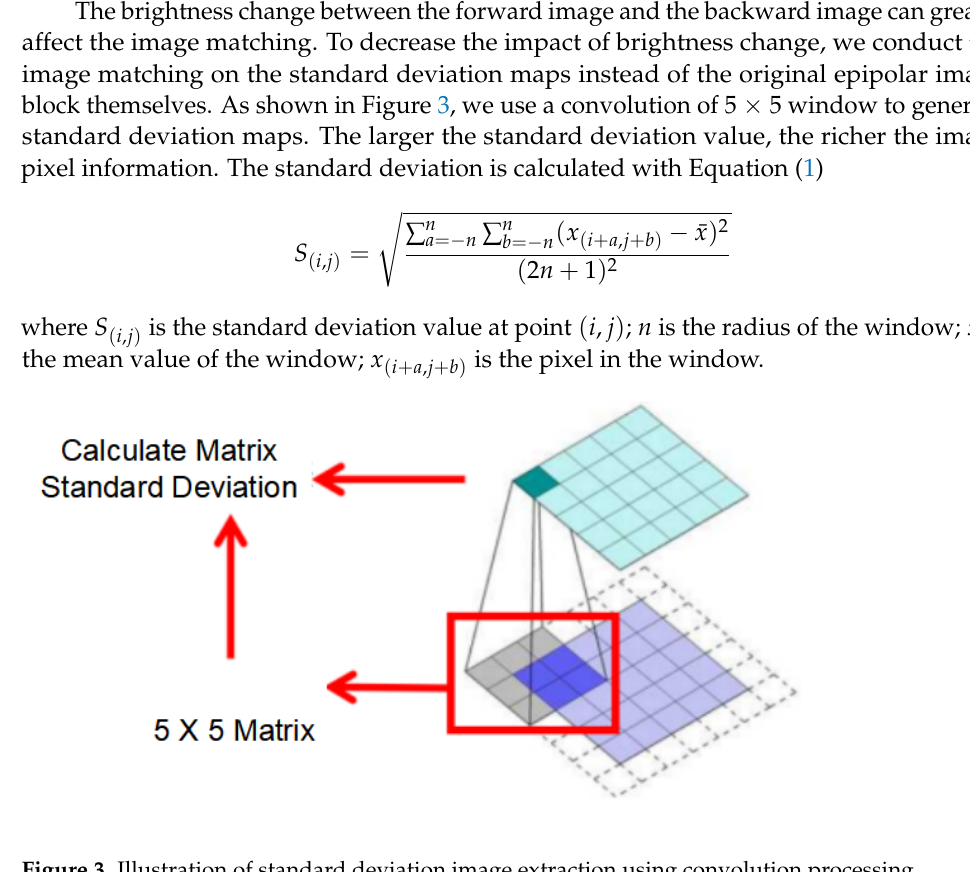
Figure 3. Illustration of standard deviation image extraction using convolution processing.